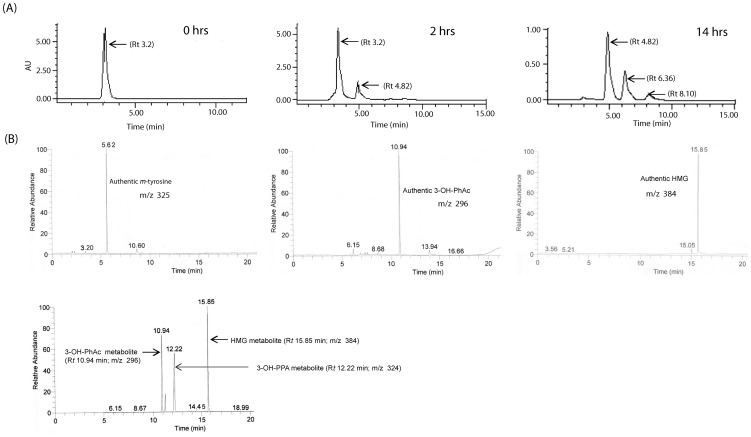
Representative HPLC and GC-MS chromatograms of intermediates identified during the degradation of m-tyrosine by resting cells of Bacillus aquimaris SSC5.(A) HPLC chromatograms of intermediates identified at different time intervals. (B) GC-MS chromatograms of TMS-derivatized authentic standards and the identified intermediates. Peaks at Rt values correspond to: 5.62 min = m-tyrosine with m/z 325; 10.94 min = 3-OH-PhAc with m/z 296; 12.22 min = 3-OH-PPA with m/z 324; 15.85 min = HMG with m/z 384.